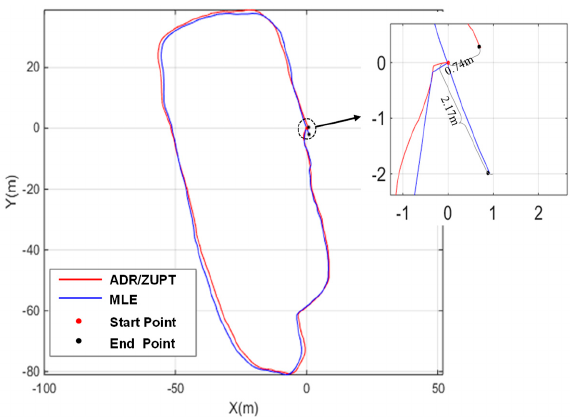
Figure 12. Positioning results of the IMU array by different methods in one closed-loop experiment.